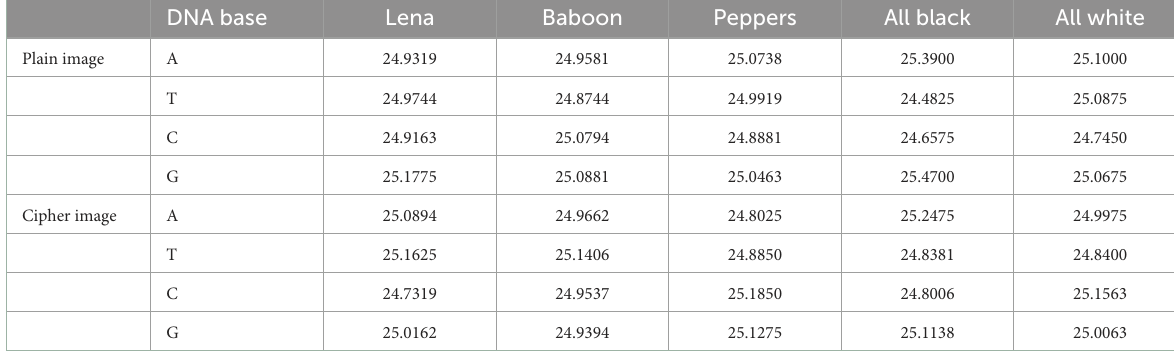
TABLE 8 Base ratio (BR) for various plain and corresponding cipher images. DNA